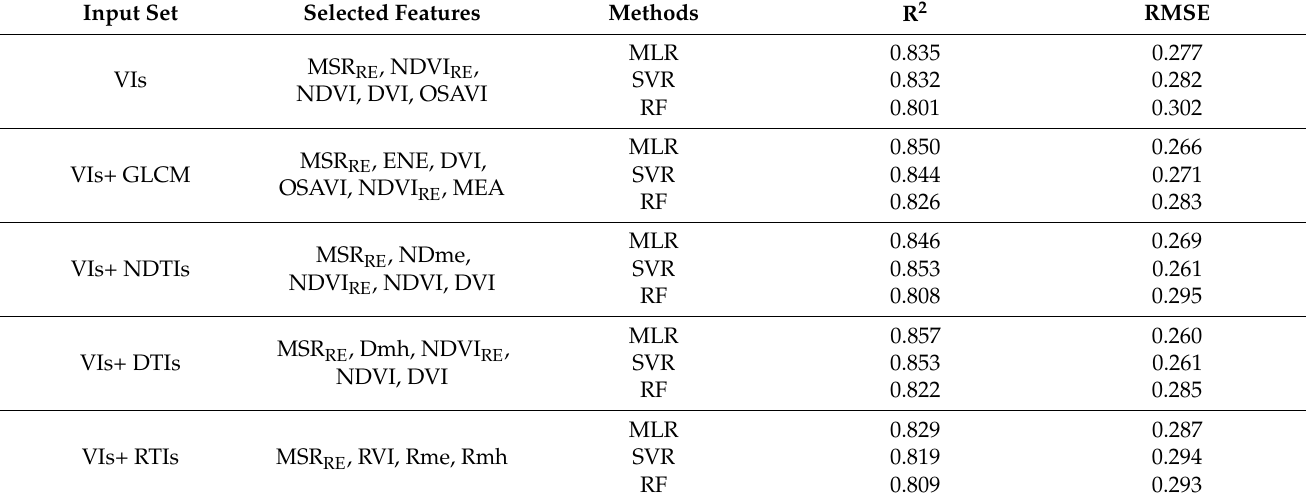
Table 8. Results of ST-based multiple regression with five input